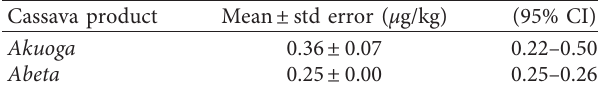
Table 4: Aflatoxin content of Abeta and Akuoga .